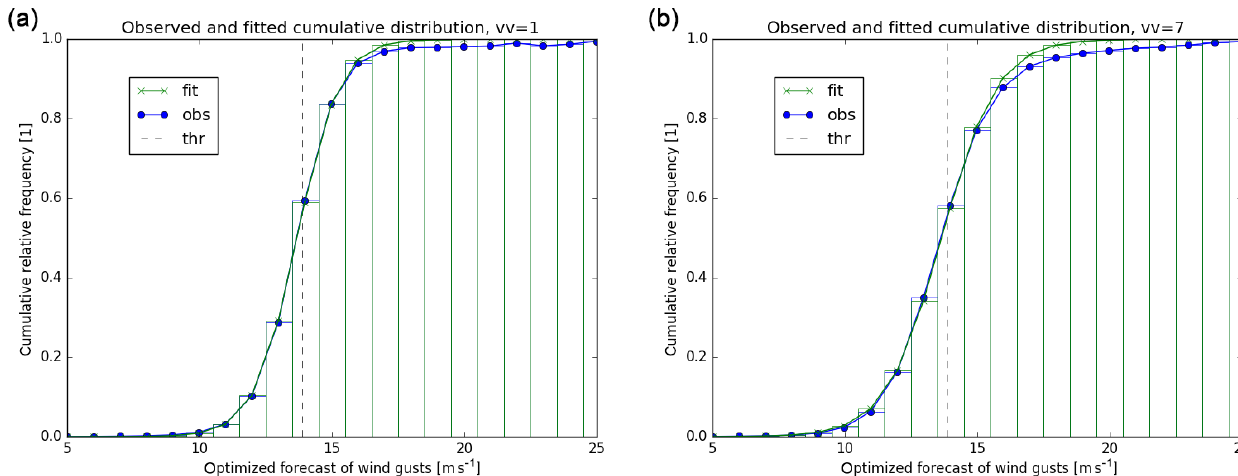
Figure 3. Observed cumulative distributions of wind gusts exceeding threshold 13.9ms − 1 (blue) and fit of logistic distribution (green) depending on statistically optimised forecasts of wind gusts for forecast lead times 1h (a) and 7h (b) . The threshold is dashed.